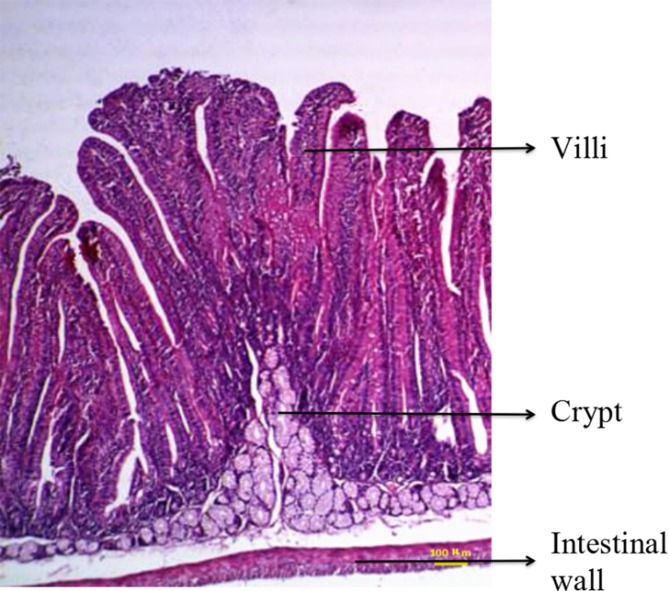
Duodenal structure of weaned rabbits (HE staining, 100×).